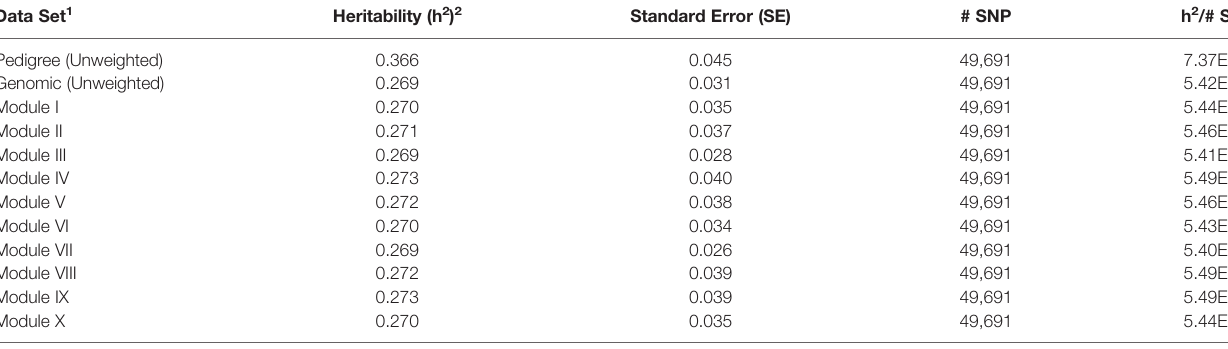
TABLE 7 | Heritability estimates for feed ef fi ciency from weighted genome-wide association studies (GWAS) utilizing all SNP. Data Set